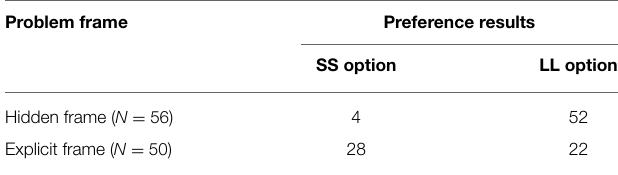
TABLE 1 | Preference results as a function of problem frame in Experiment